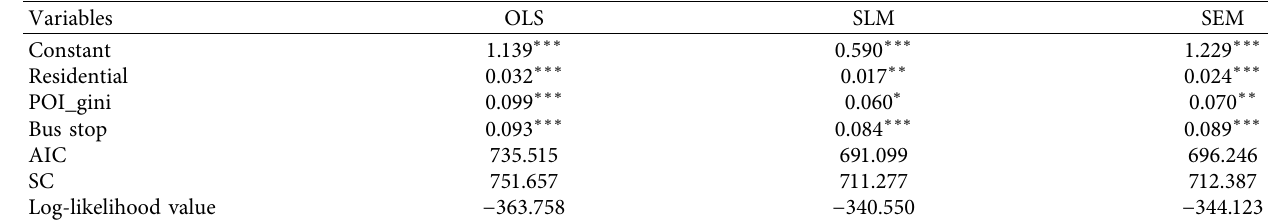
Table 5: Estimation